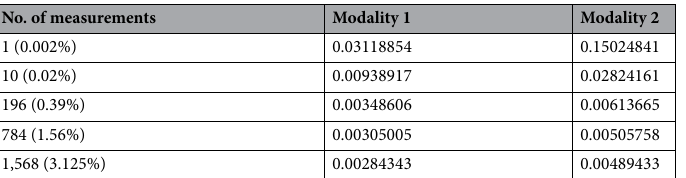
Table 2. Compressed sensing mean reconstruction error over a batch of 50 WiFi spectrogram data samples (No additive Gaussian noise). An illustration is shown in Fig. 4.